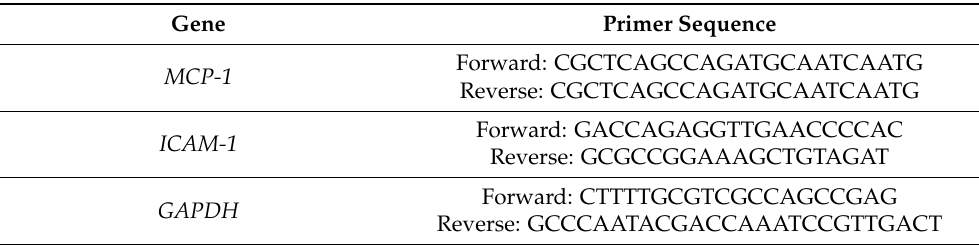
Table 3. Primer Sequences used for human MCP-1, ICAM-1 and GAPDH genes. Gene Primer Sequence Forward: CGCTCAGCCAGATGCAATCAATG MCP-1